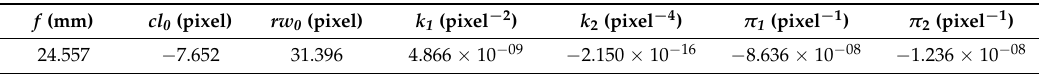
Figure 13. Histogram of reprojection error vector after self-calibration in pixels, including one scale bar distance for traceability (Figure 10, in orange), with RMS value being 0.18 pixel. Table 6. Camera intrinsic parameters after self-calibration.